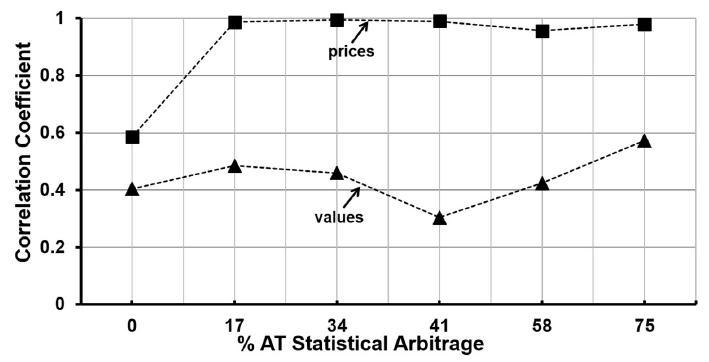
Figure 2. Impact of AT on relation between price and fundamentals.